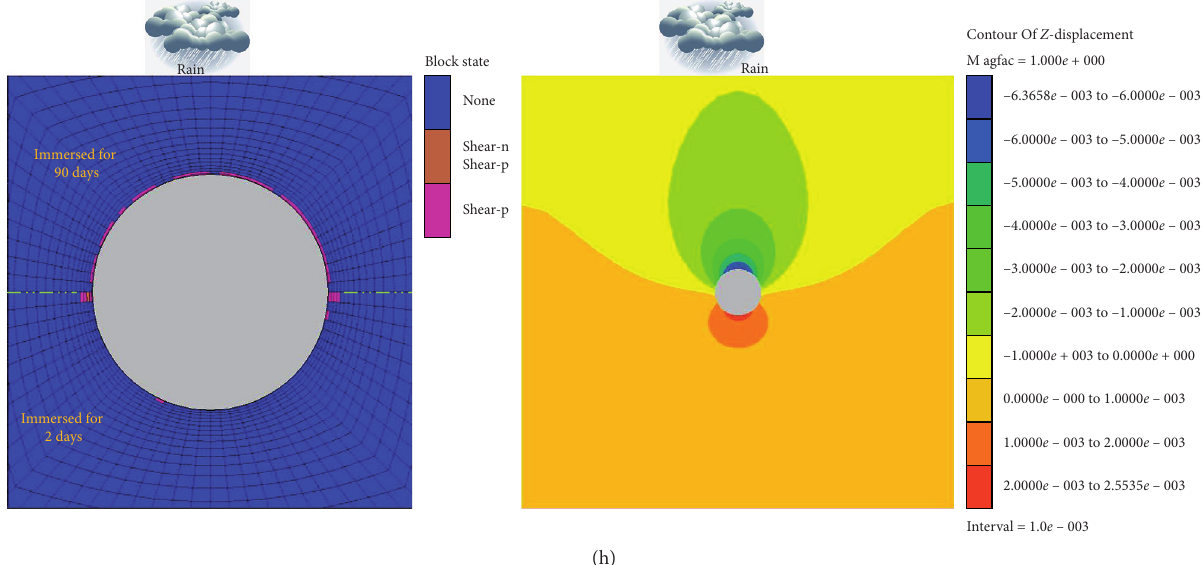
Figure 9: Block state and contour of z-displacement in the surrounding rock: (a) under 0 days of water immersion; (b) under 2 days of water immersion; (c) under 15 days of water immersion; (d) under 30 days of water immersion; (e) under 50 days of water immersion; (f) under 70 days of water immersion; (g) under 90 days of water immersion; (h) under rainfall circumstance with upper strata immersed for 90 days and lower strata immersed for 2 days.